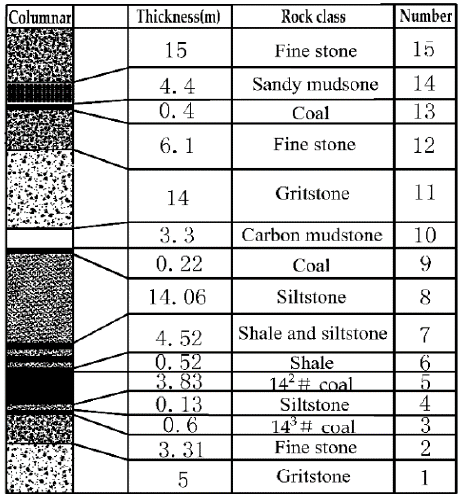
Figure 1. The composite columnar section.